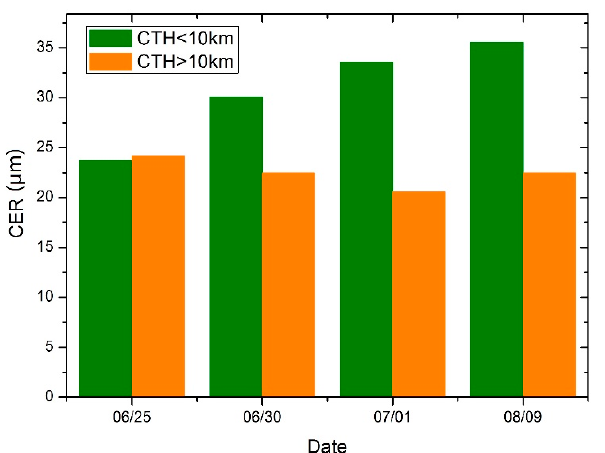
Figure 15. Comparison of the cloud effective radius (CER) over the CTH > 10 km region (orange bar) and CTH < 10 km region (green bar). Histograms are for 25 June, 30 June, 1 July and 9 August 2021.